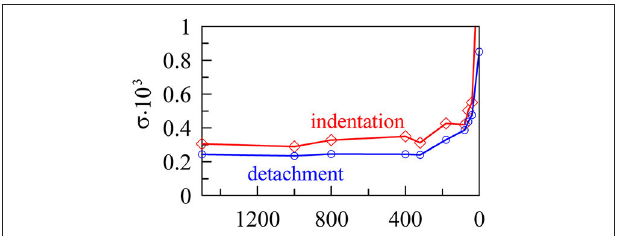
FIGURE 12 | Dependency of the variable σ characterizing the typical jumps in contact area vs. sandpaper grit number for indenter with radius R =